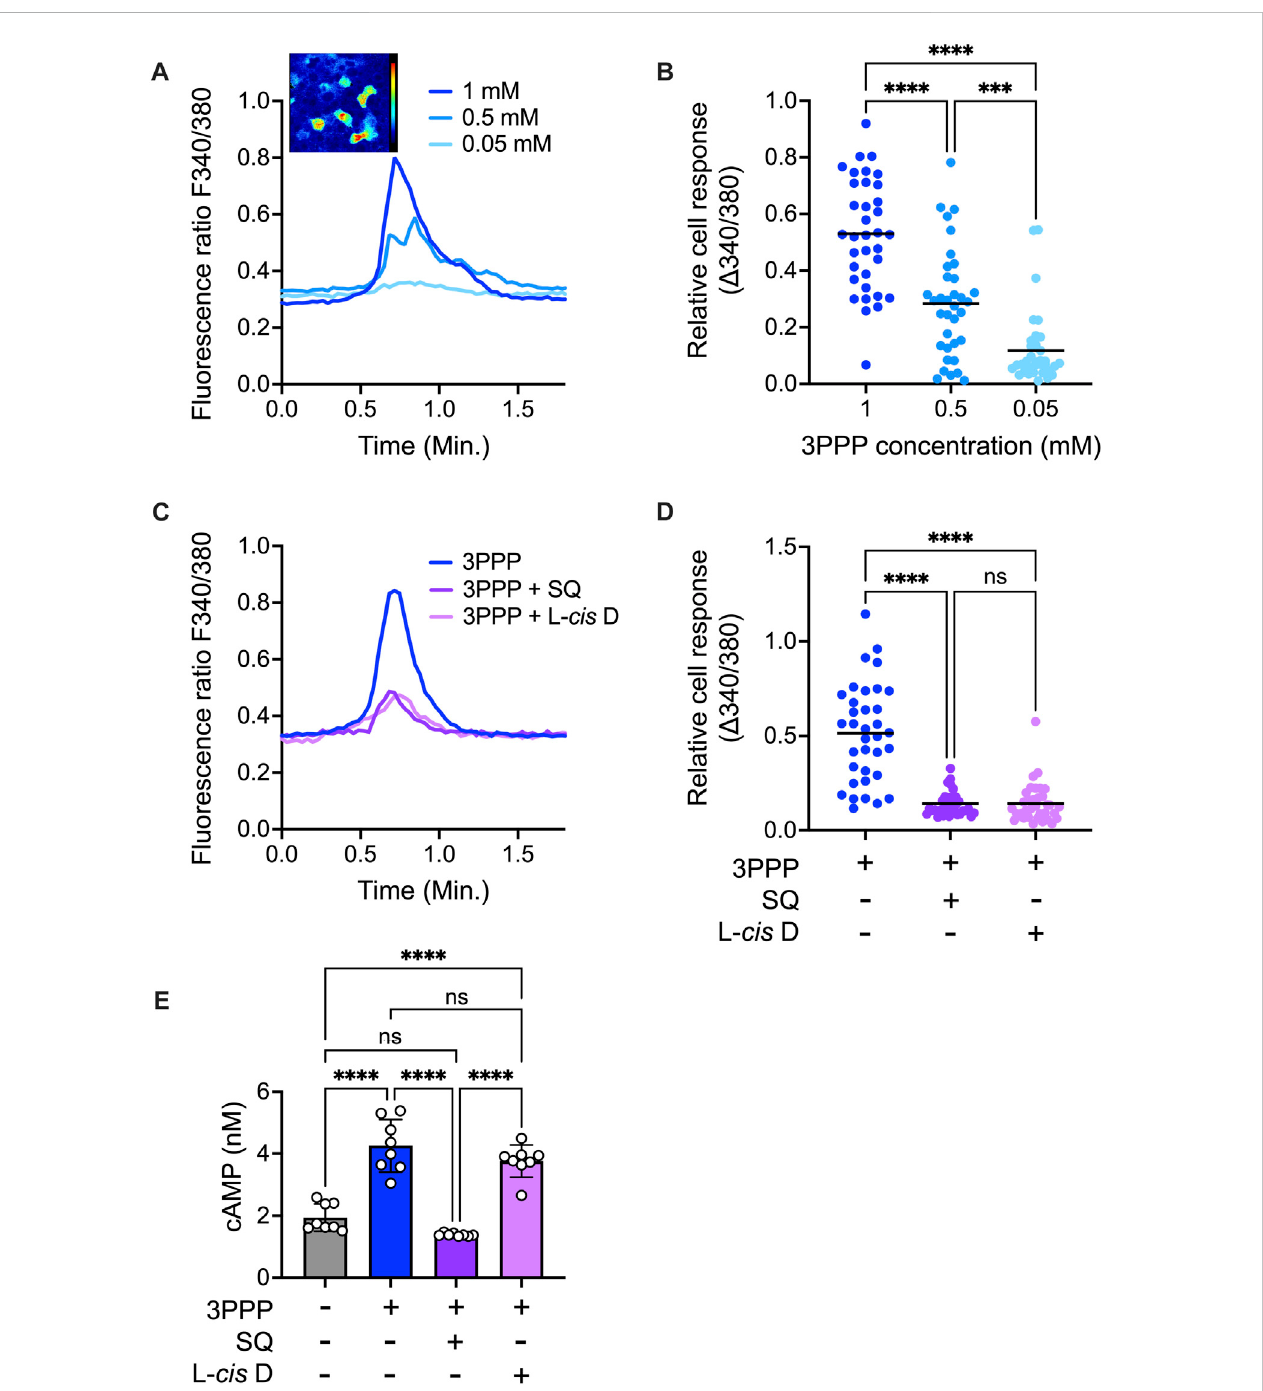
FIGURE 4 Calcium response and cAMP production induced by 3PPP in keratinocytes. (A – C) Representative pro fi les of intracellular calcium after 3PPP (1 mM for (C) ) application with or without SQ-22536 (100 μ M) and L- cis -diltiazem (100 μ M) to the cells. Representative image of cells at 0.75 min in condition of 3PPP (1 mM) application is indicated in (A) . (B – D) Quantitation of fl uorescence ratio change after application of 3PPP (1 mM for (D) ) with or without SQ-22536 (100 μ M) and L- cis -diltiazem (100 μ M) to the cells. Anova F value = 49.38 and p < 0.0001 for (B) , Anova F value = 59.58 and p < 0.0001 for (D) ( n = 35 cells). (E) cAMP measurement after application of 3PPP (1 mM) with or without SQ-22536 (100 μ M) and L- cis -diltiazem (100 μ M) to the cells. Anova F value = 52.38 and p < 0.0001 ( n = 8). Similar results were obtained in three independent experiments. Bars and lines represent mean ± SD. ***: p <